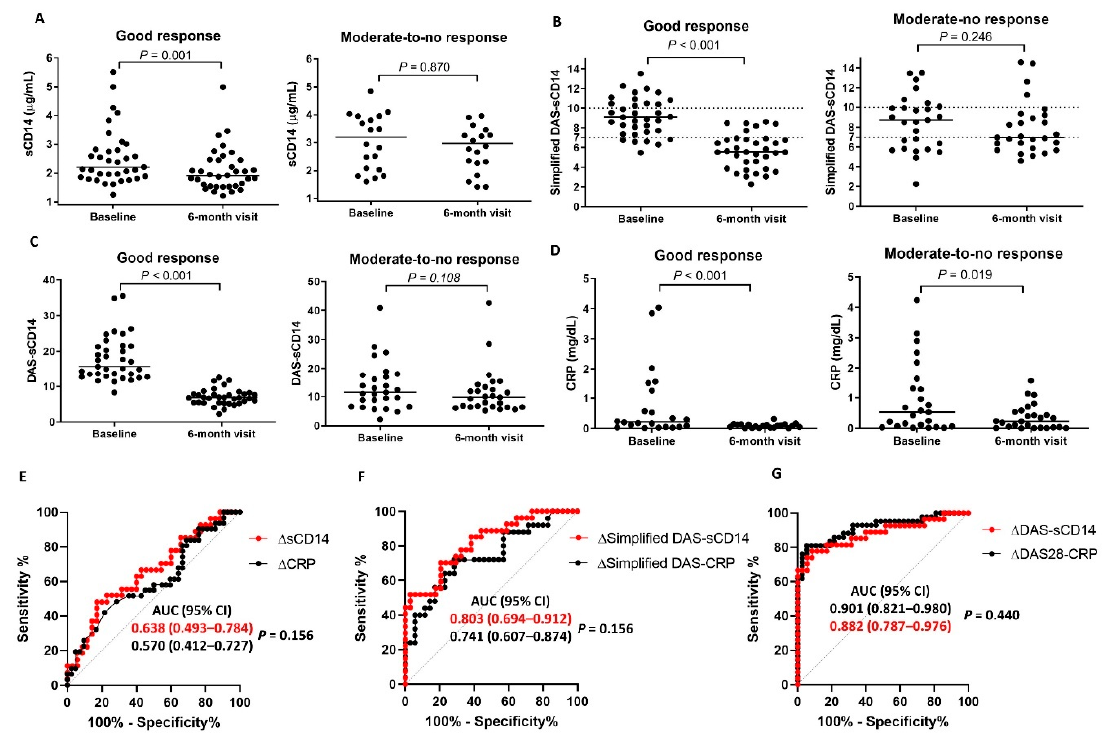
Figure 4. Levels of serum sCD14 (measured by FREND ™ ) DAS28 CD14 , simplified DAS CD14 , and CRP according to treatment response. ( A – C ) The results for serum sCD14 ( A ), DAS28 CD14 ( B ), simplified DAS CD14 ( C ), and CRP ( D ) are shown at baseline and at 6 months post-treatment with anti-rheumatic drugs. Good, moderate, and no response were defined according to European League Against Rheumatism (EULAR) response criteria. ( E – G ) The AUC analysis of the ability of Δ sCD14 ( E ), Δ DAS28 CD14 ( F ), and the Δ simplified DAS CD14 ( G ), calculated as the level at baseline to the level at 6 months after treatment with anti-rheumatic drugs, to distinguish a good response from a moderate-to-no response. The AUC of Δ CRP and Δ simplified DAS CRP (=0.1 × PGA + CRP [mg/dL]) are shown for comparison.